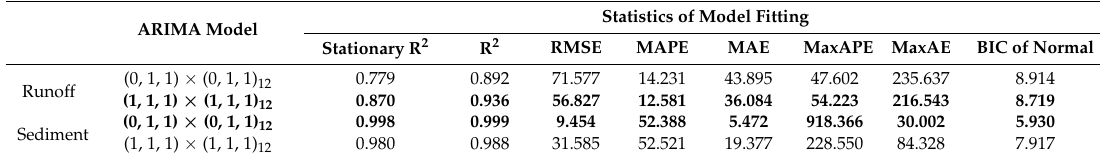
Table 4. Statistics of ARIMA model fitting for runoff and sediment sequences.